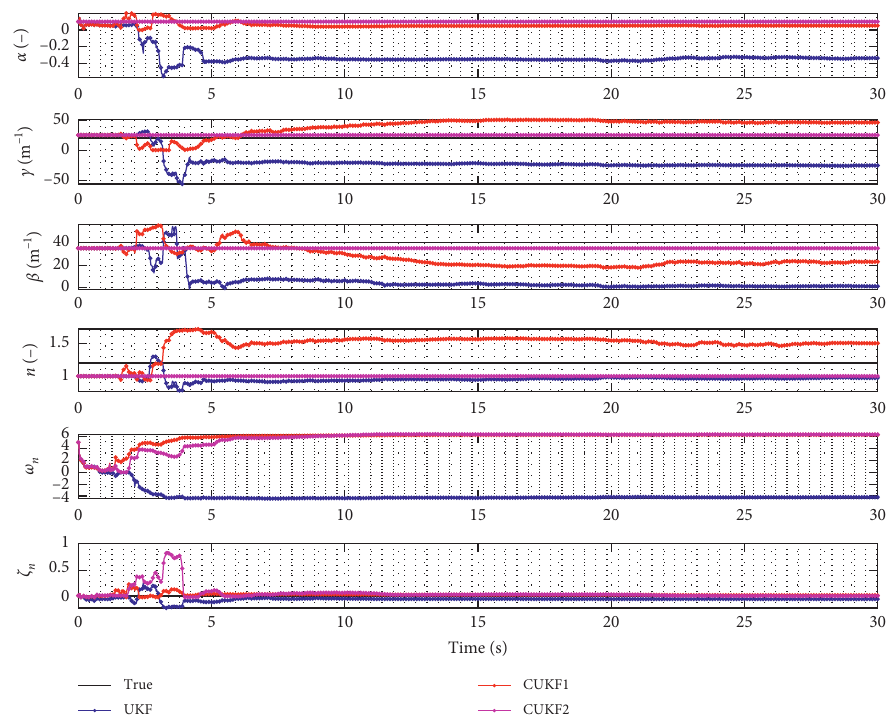
Figure 5: Results of parameter identification for Example 2.